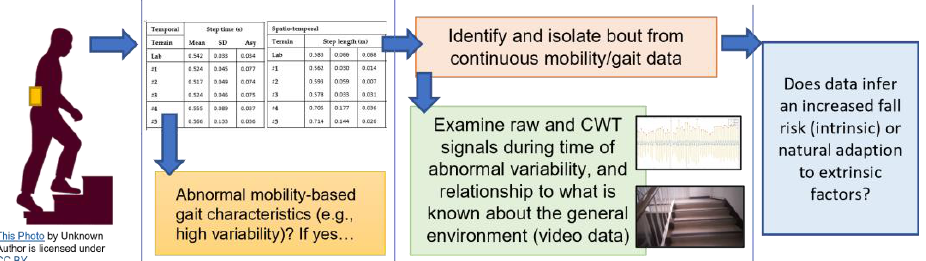
Figure 5. Left to right, although common algorithms for spatio-temporal processing for data collect on L5 are not specifically designed for e.g., stair ambulation, they may still be useful tools to help inform fall risk when used with video data for a more rounded mobility assessment.